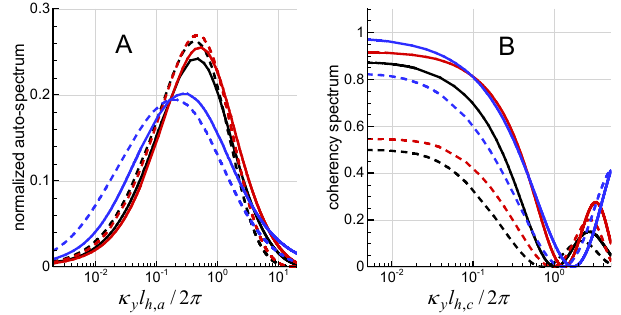
Figure 2. Theoretical auto-spectra (A) and coherency spectra (B) for altitudes h 0 = 40km (solid lines) and h 0 = 34km (dashed lines), for different models of the following atmospheric irregu- larities: black – the model of Gurvich and Brekhovskikh (2001) with the constant anisotropy, red – the model of Gurvich and Chunchuzov (2008a, b) with η(κ z ) = Const, blue – the model of Gurvich and Chunchuzov (2008a, b) with variable anisotropy. Auto- spectra are presented as the product of power spectral density multiplied by wave number and normalized by scintillation vari- ance. On the x-axes, the normalized wave numbers are κ y l h,a / 2 π = κ y l W η(κ W )/ 2 π for auto-spectra and κ y l h,c / 2 π = κ y 1 c η(1 − 1 c ) for coherency